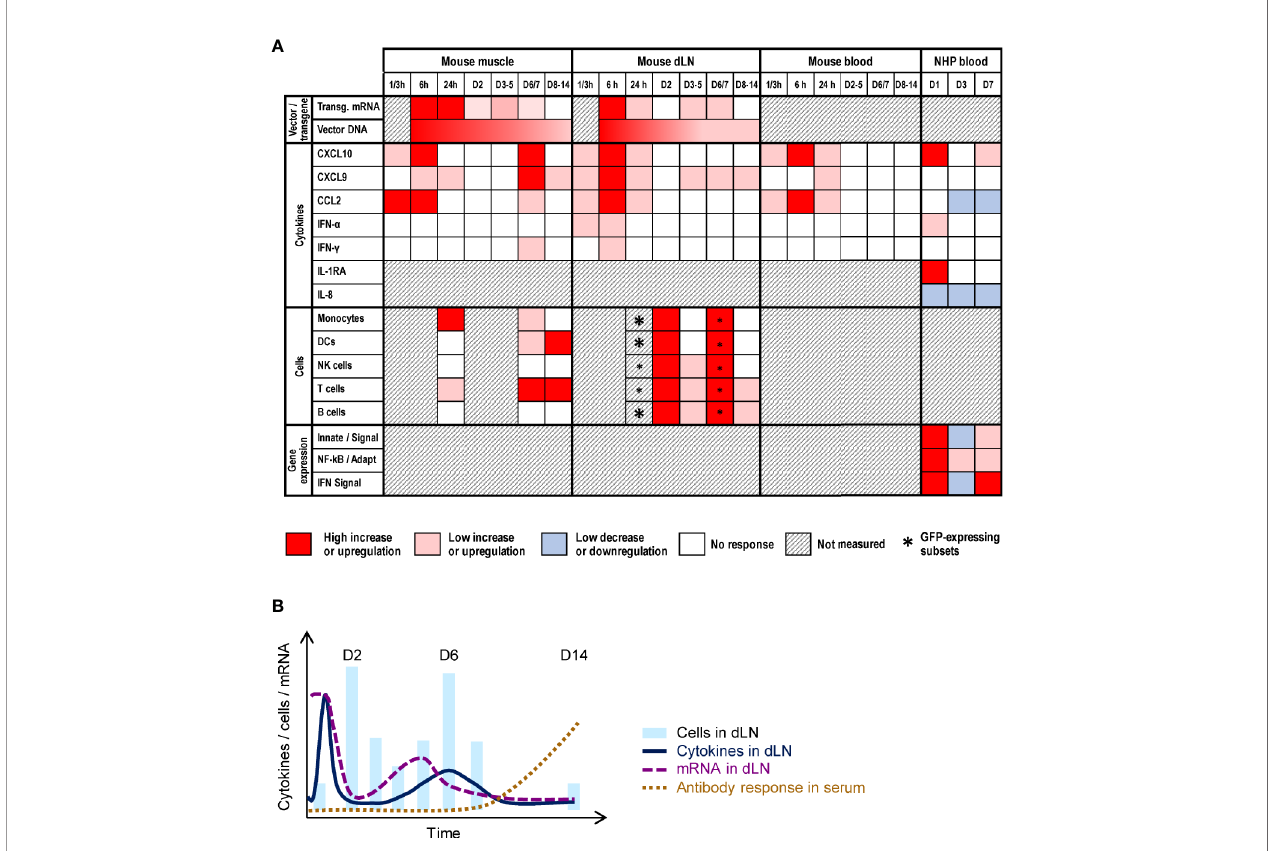
FIGURE 7 | Conceptual data integration. (A) Conceptual heat map representing the response levels in the injected muscle or draining lymph node (dLN) from mice, or in peripheral blood from mice or non-human primates (NHP) after intramuscular immunization with ChAd155-vectored vaccines. Blood responses were measured in serum (cytokines, in both animal models) or whole blood (gene expression). Colors represent the qualitative response intensity as compared to pre-vaccination levels, as indicated in the color key below the fi gure. Asterisk sizes correspond to relative response levels. Indicated gene expression refers to the following pathways in Figure 6B : “ Innate/signal ” , innate immunity signaling pathways (nos. 1 – 5 and 8 – 11); “ NF-KB/Adapt ” , NF-kB and adaptive immunity pathways (nos. 6 and 7); and “ IFN signal ” , interferon signaling pathway (no. 12). (B) Diagram representing hypothetical model of transgene mRNA expression and immune response in the dLN elicited after immunization. Transgene mRNA expression peaks shortly after injection, but is rapidly dampened, likely by the fi rst wave of cytokine/chemokine release and subsequent cell mobilization (D2). Upon contraction of this fi rst innate response wave around D4 – D5, a residual reservoir of ChAd155-infected cells instigates a reactivation of viral gene expression, and consequently also of innate immune responses (D6 – D7). These responses are then followed by adaptive immunity, including the antigen-speci fi c antibody response which was detectable in the serum from